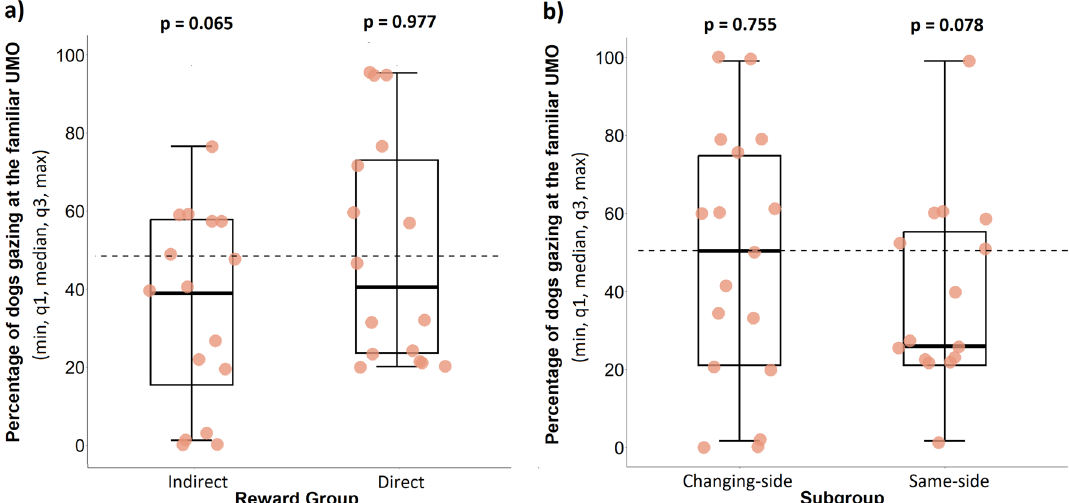
Figure 5. Percentage of dogs gazing first at the familiar UMO in the ( a ) Reward groups and ( b ) Location subgroups after release. The dashed line indicates the chance level of gazing at the familiar UMO first 50% of the time which would be the result if the dogs did not have a preference for either UMO. The p -values indicate whether dogs first gazed at the familiar UMO significantly above or below